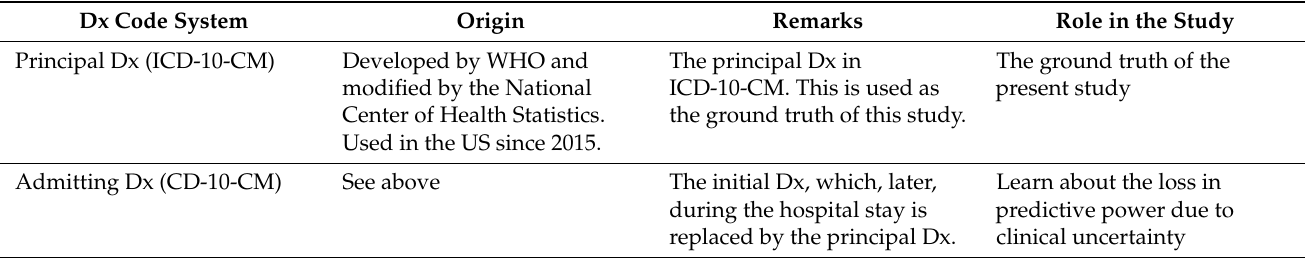
Table 1. Description of the Dx classification systems and their role in the present